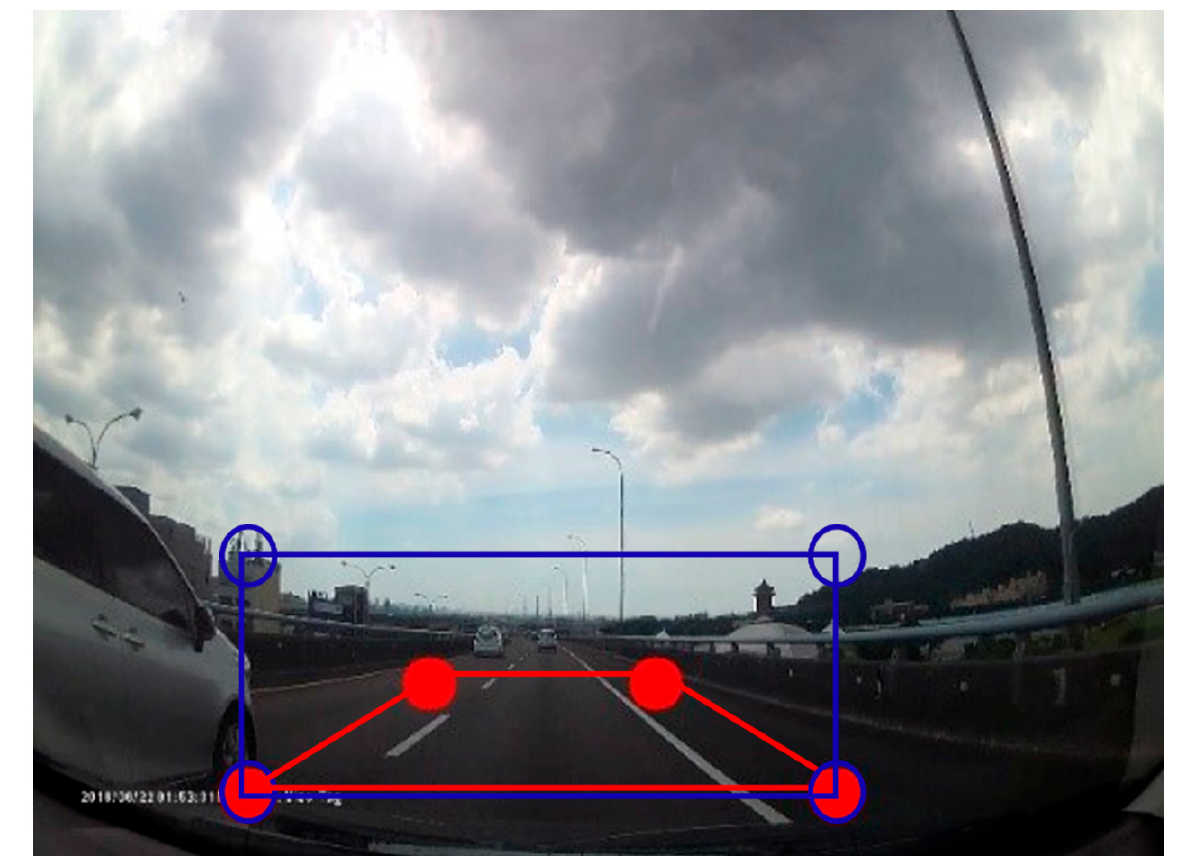
Figure 13. Eight points on the road images.